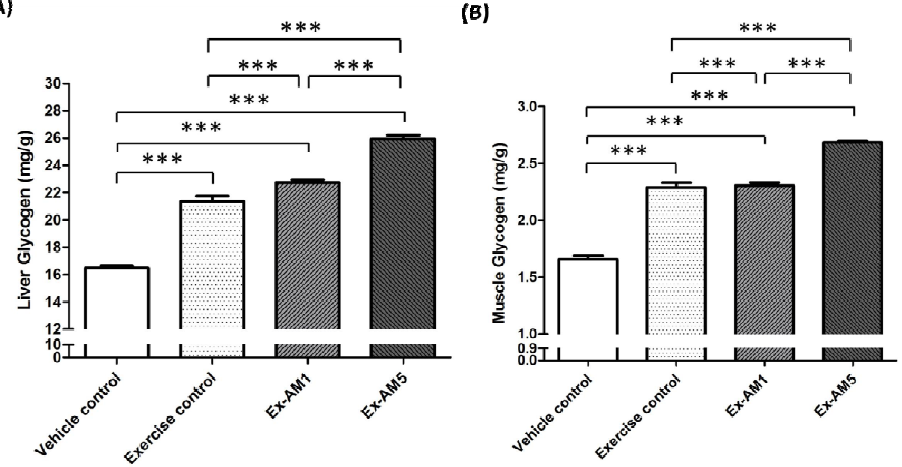
Figure 3. Effect of AM supplementation on levels of hepatic glycogen ( A ) and muscle glycogen ( B ). Data are mean ± SEM of n = 10 mice in each group by one-way ANOVA. *** p < 0.001.